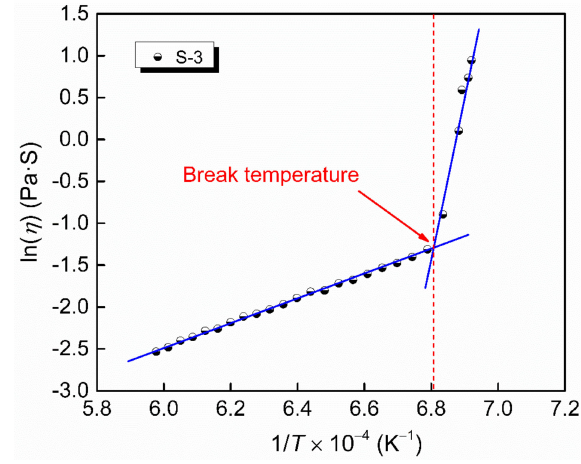
Figure 6. The natural logarithm of viscosity versus inverse absolute temperature of slag S-3.